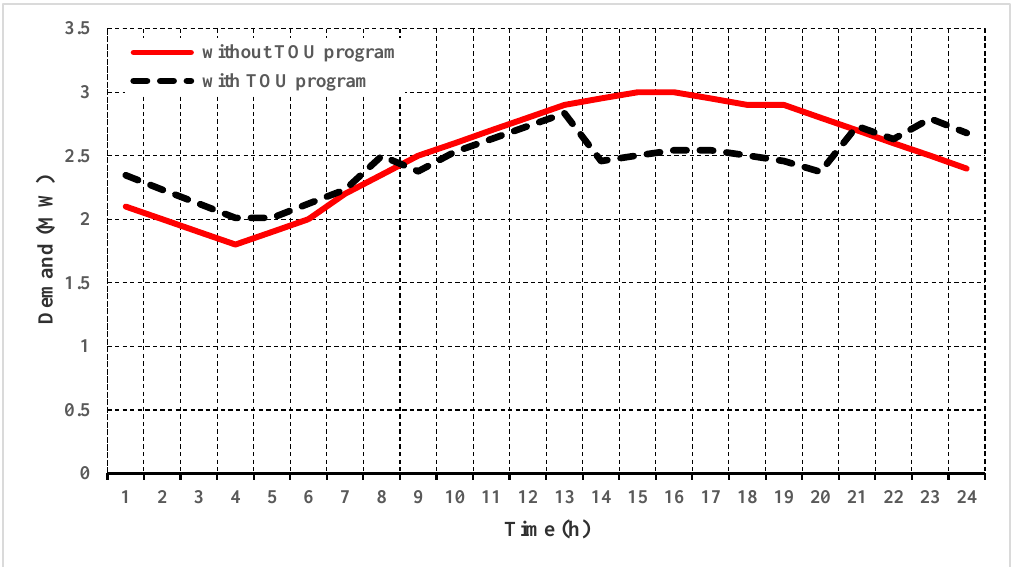
Figure 5. Demand of the customer with/without the TOU program. Table 7. The amount of the revenue and cost in TOU programs ( β = 0, 1).